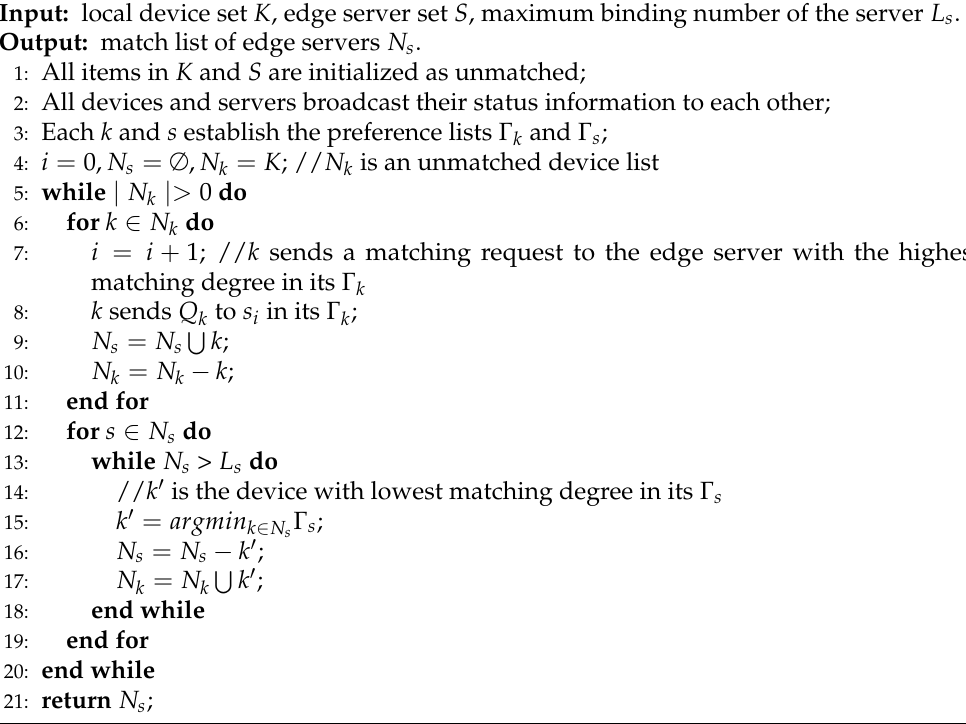
Algorithm 1 Preference-based stable matching